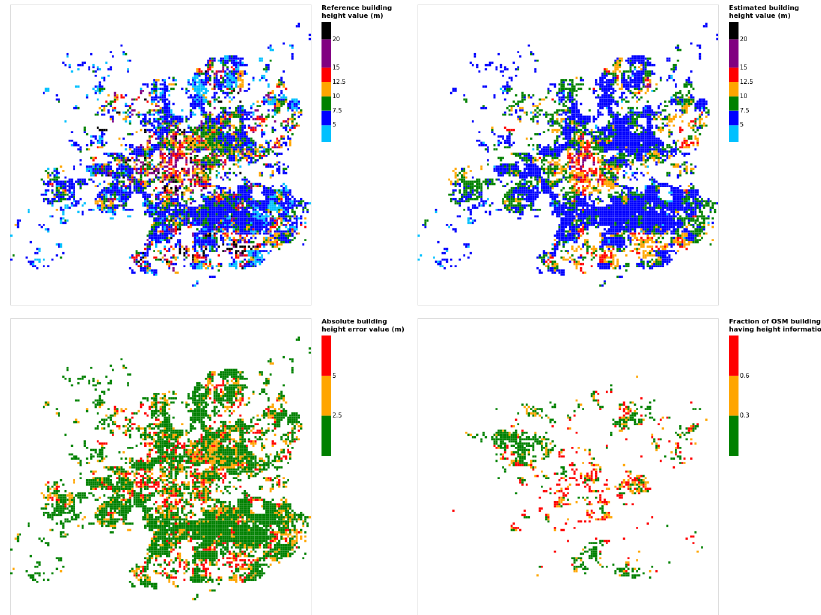
Figure B19. Results for the commune at grid cell (upper left panel) reference building height, (upper right panel) estimated building height, (lower left panel) absolute building height error, and (lower right panel) fraction of OSM buildings that have height information. For all panels except the lower right, only cells that have buildings – with at least 90% of their buildings having no height value in OSM – are displayed.